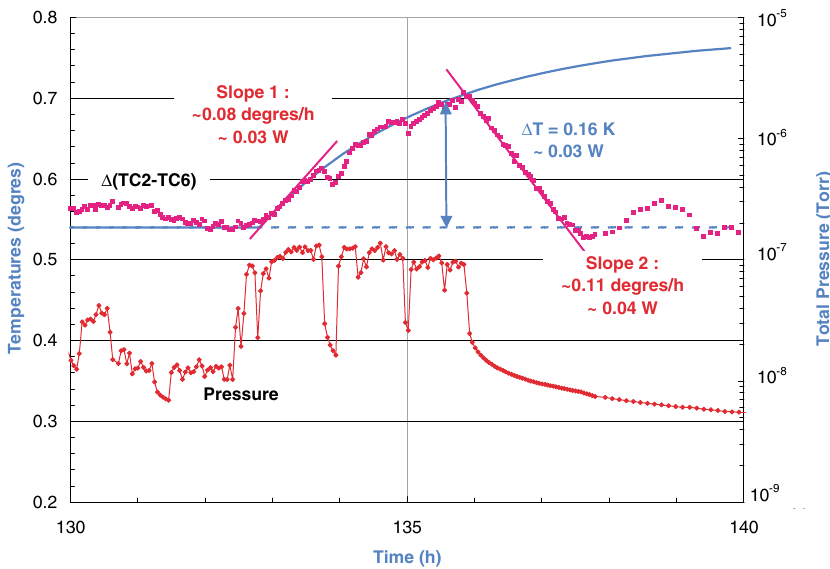
FIG. 5. (Color) Detail of the relative temperature increase observed during electron cloud activity of Fig. 4.